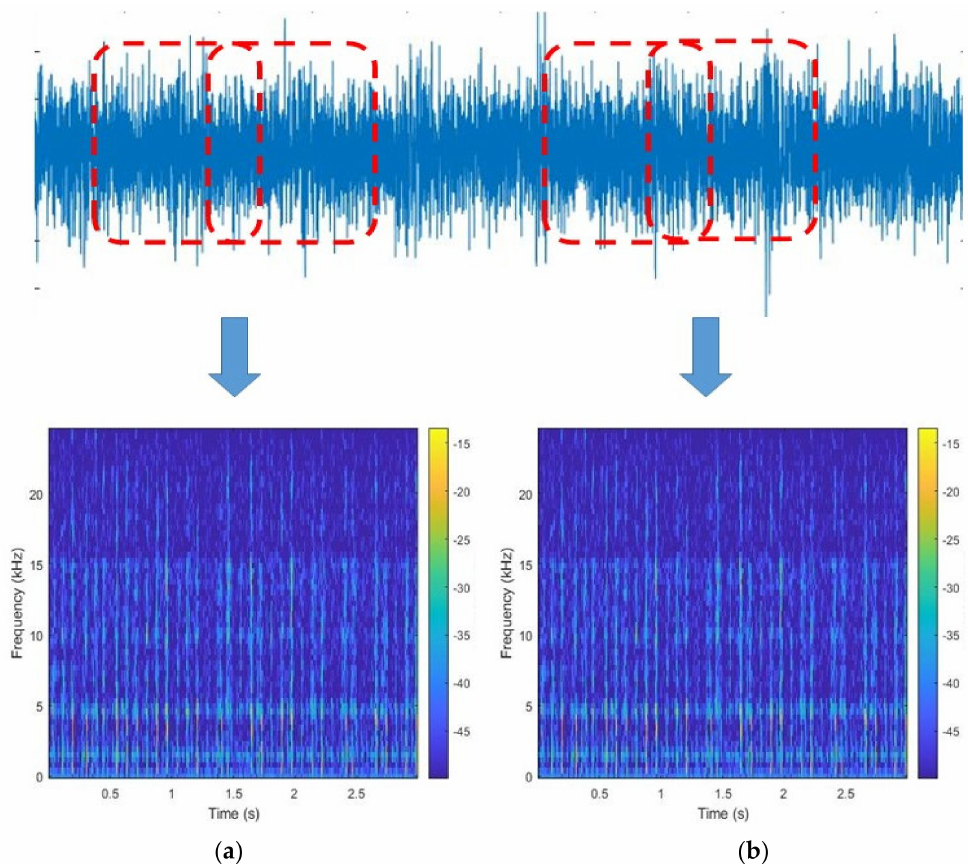
Figure 4. Conversion from vibration signal to time–frequency domain image.